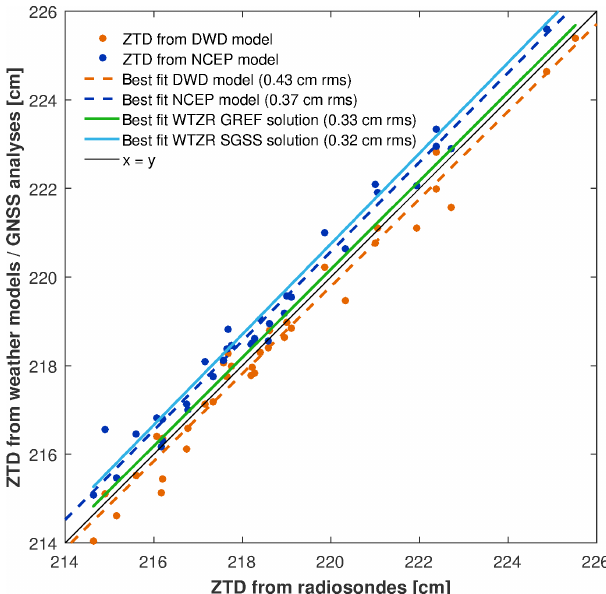
Figure 10. Linear regression between zenith total delays (ZTDs) derived from radiosonde data and those derived from numerical weather models and GNSS